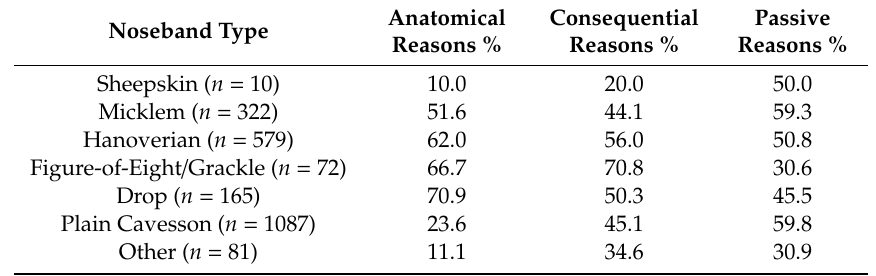
Table 7. Distribution across noseband types of Anatomical, Consequential or Passive reasons for noseband use ( n = 2316).